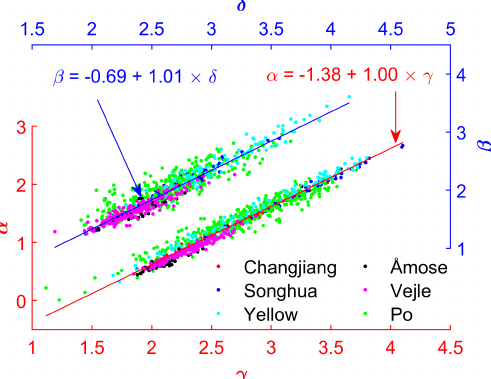
Figure 2. Linear relationship between α/β and γ/δ . Each dot repre- sents one cross-section of a certain river. Dots of the same color are from the same river. Manning’s coefficient for each cross-section is randomly generated between 0.015 and 0.05. Note that the best- fit line for each river is slightly different. The relationship using a uniform Manning’s coefficient of 0.03 is also given in Fig. A3. In- dividual fitting lines are shown in Fig.